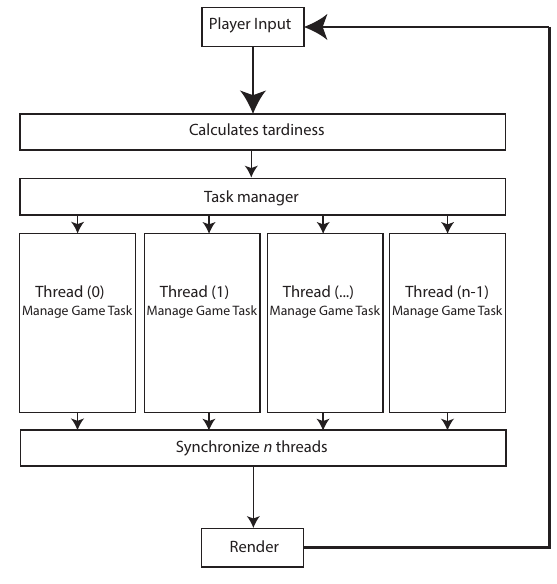
Fig. 4: The proposed game loop architecture.